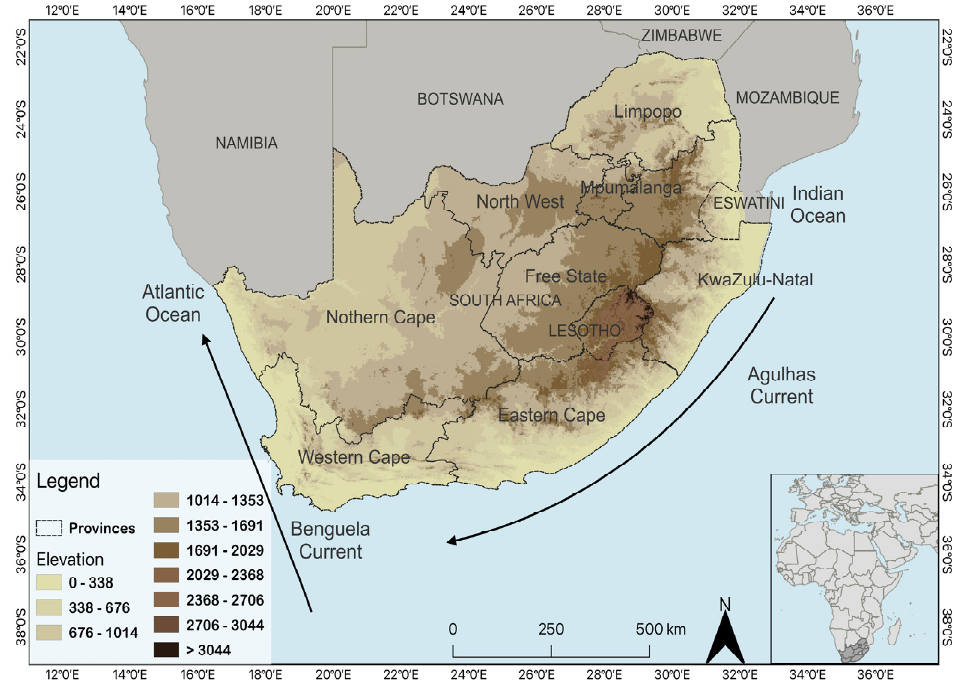
Figure 1. Map of the study site of South Africa indicating the nine provinces, topography, the surrounding oceans, and their respective currents.